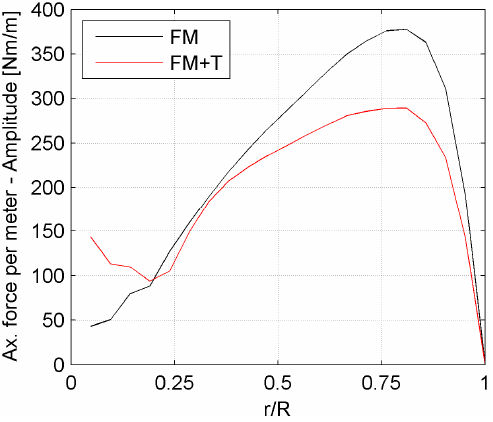
Figure 16. Amplitude of the axial force oscillation as a function of the span: FM vs FM + T.